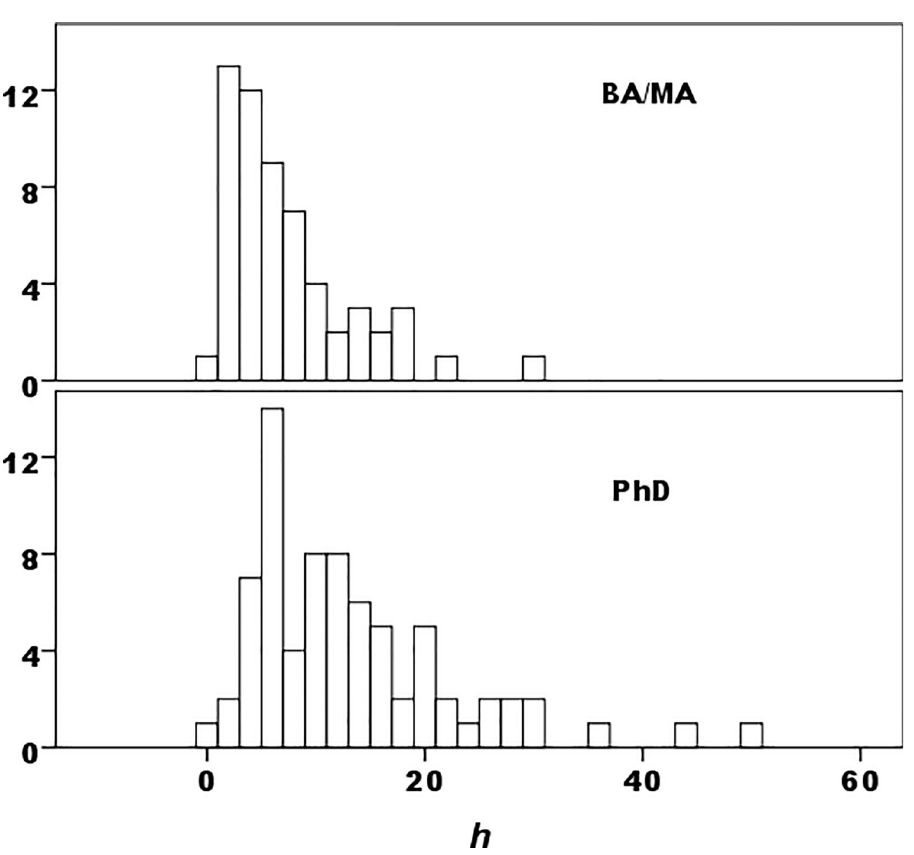
Fig 4. Distribution of h by combined BA+MA versus PhD